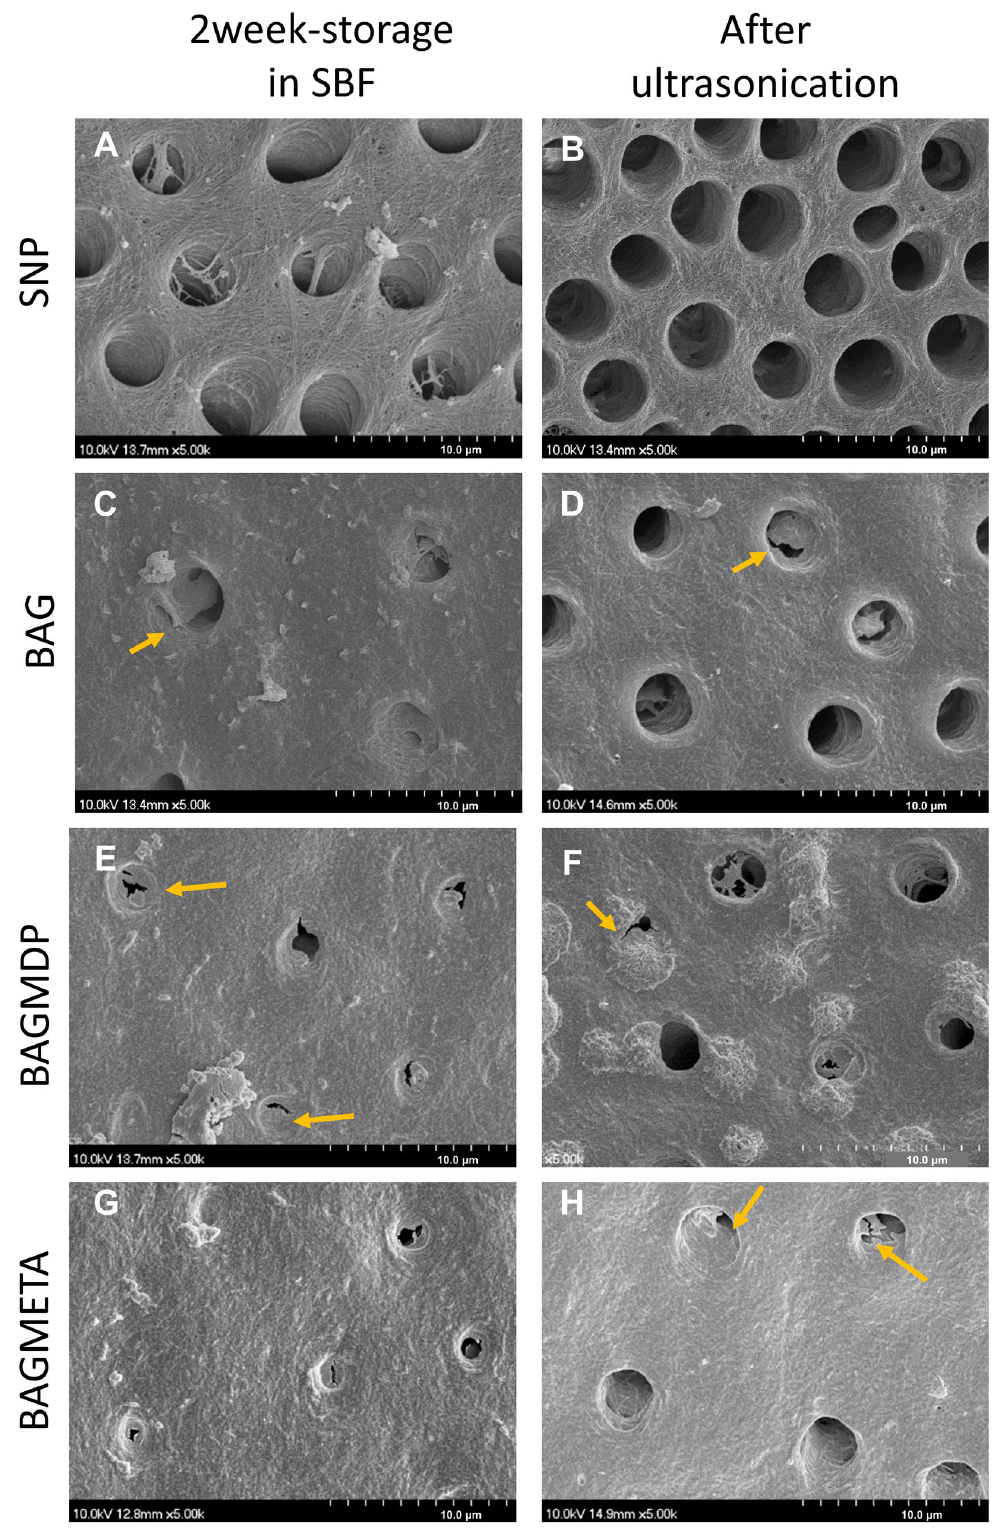
Figure 5. Representative SEM images of dentin surfaces: ( A,B ) SNP, ( C,D ) BAG, ( E,F ) BAGMDP, and ( G,H ) BAGMETA groups. SNP group ( A,B ). Left column images show the dentin surface after 2-week storage period in SBF, and right column images show the dentin surface after application of ultrasonication. The images present that the BAG-containing groups occluded exposed dentin surfaces with precipitates (arrows) and those occlusions were retained after the ultrasonication.